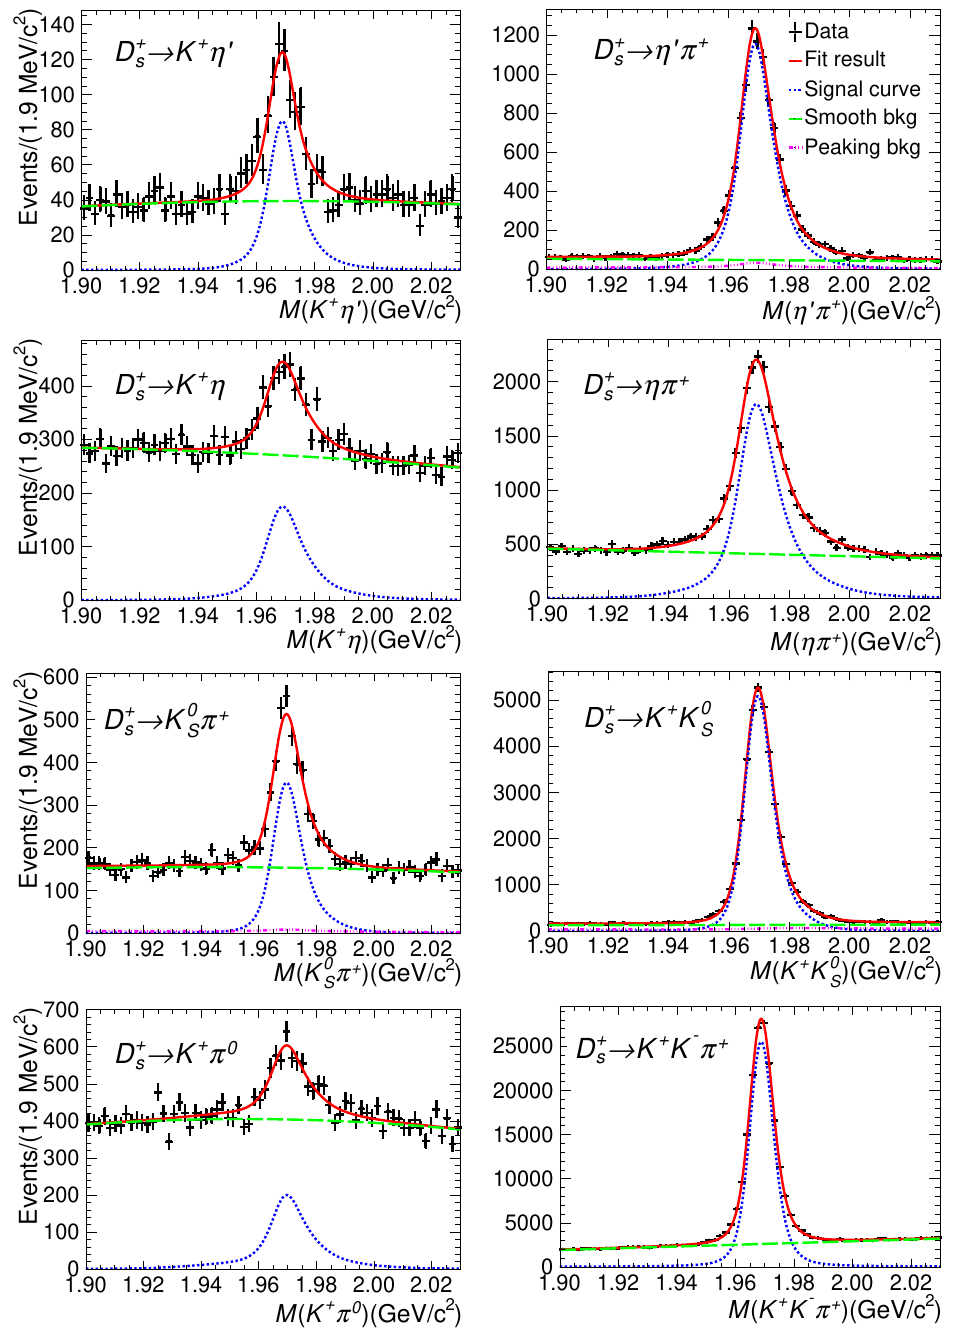
Figure 2 . Fits to the invariant mass spectra of the signal candidates in data (shown as dots with error bars). The solid lines are the (cid:12)t results, the dotted lines are the signal components, the long dashed lines are the non-peaking backgrounds and the dotted dashed lines are the peaking